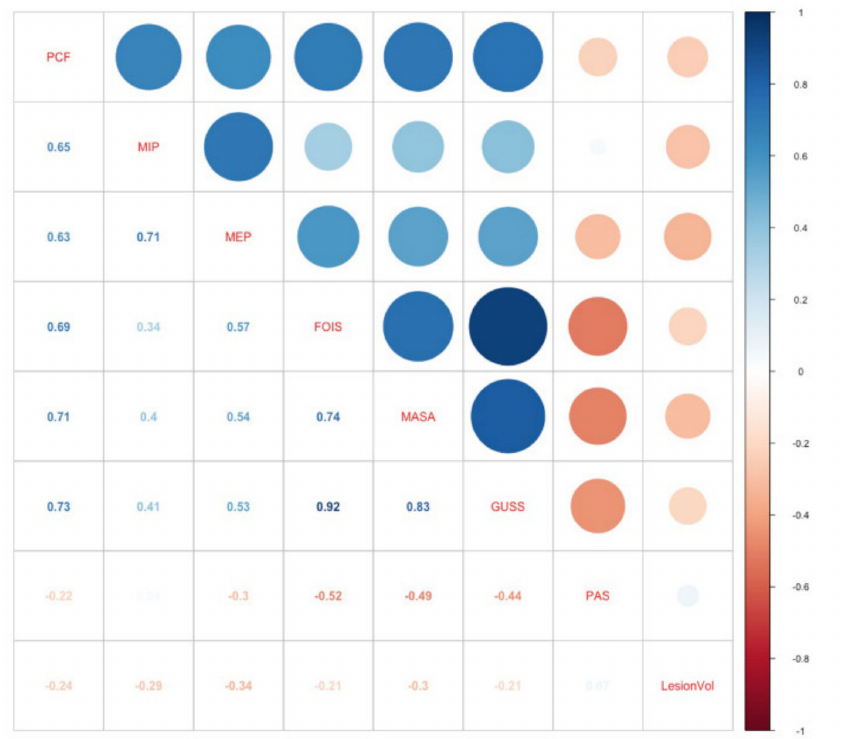
Figure 3. Heat map of the correlation coe ffi cients (Spearman) between the peak cough flow (L / min) and the degree of dysphagia and aspiration, which are displayed in di ff erent colors. The color scale indicates the degree of correlation (blue, strong positive correlation; white, weak correlation; red, strong negative correlation). PCF: peak cough flow; MIP: maximal inspiratory pressure; MEP: maximal expiratorypressure; FOIS:FunctionalOralIntakeScale; MASA:MannAssessmentofSwallowingAbility; GUSS: Gugging Swallowing Screen; PAS: Penetration Aspiration Scale; LesionVol: Lesion